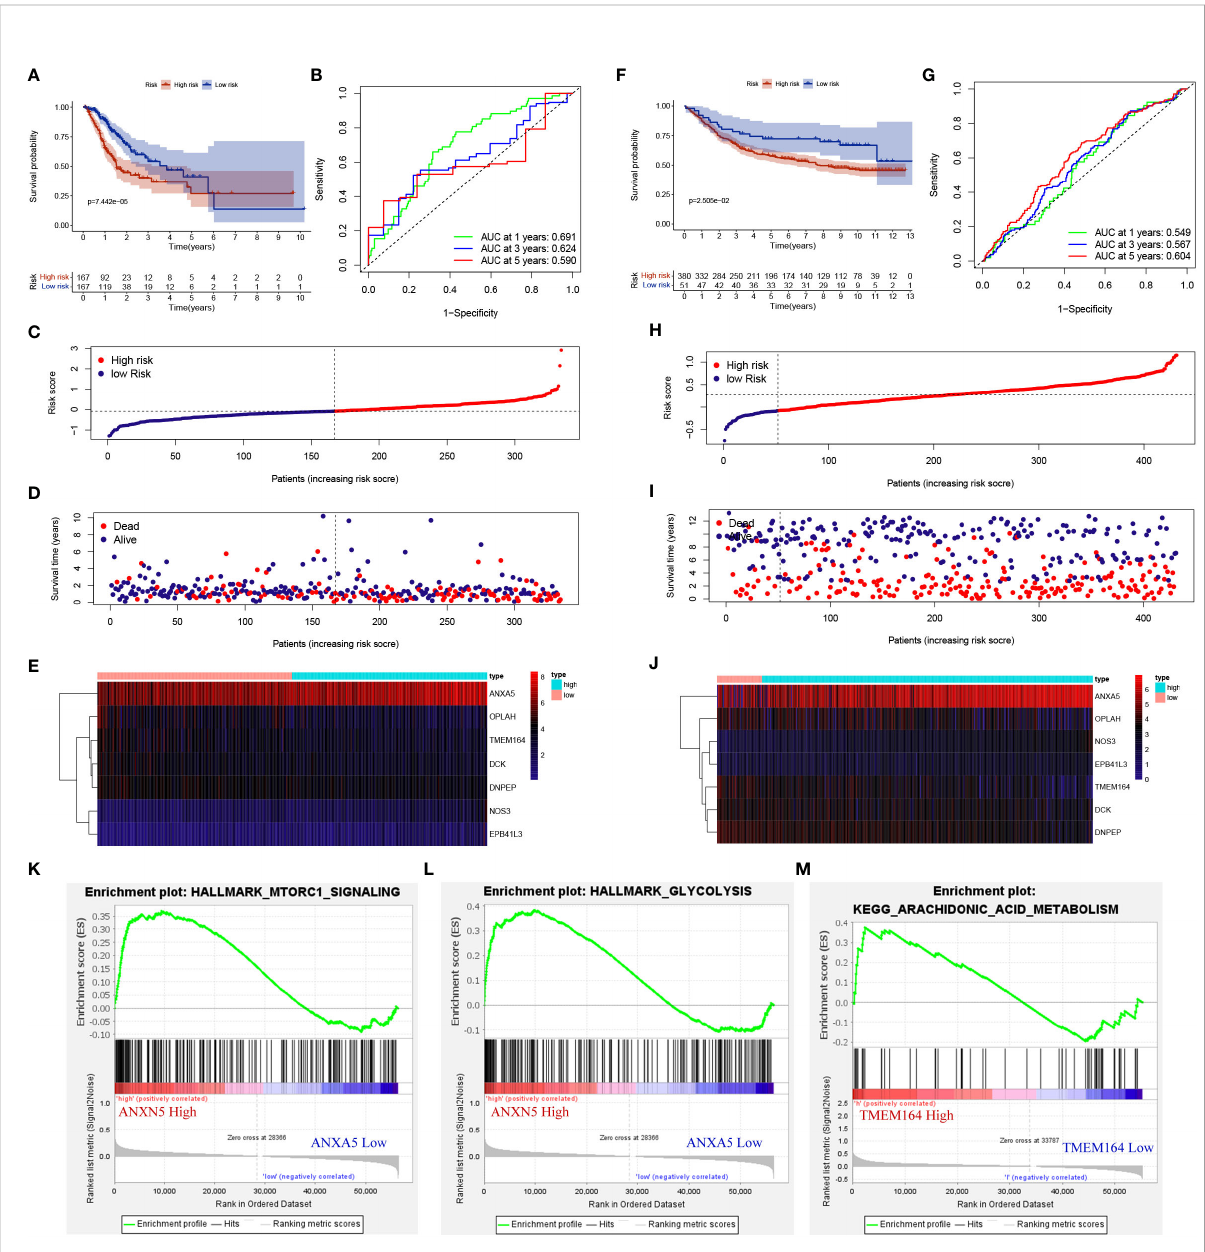
FIGURE 3 METTL3-regulated DEPs affected the prognosis of GC patients and were involved in cellular energy metabolism. (A, F) K-M survival curves for high- and low-risk groups in training set and testing set. (B, G) ROC curves for sensitivity and speci fi city of risk models used to predict 1-, 3- and 5- year survival in training set and testing set. (C, D, H, I) Scatter plot of DEPs risk scores and patient survival, with red and blue dots representing high- and low-risk patients in training set and testing set. (E, J) Expression of gene used to construct risk models in training set and testing set. GSEA gene enrichment of high-risk group with ANXA5 (K, L) and TMEM164 (M) high